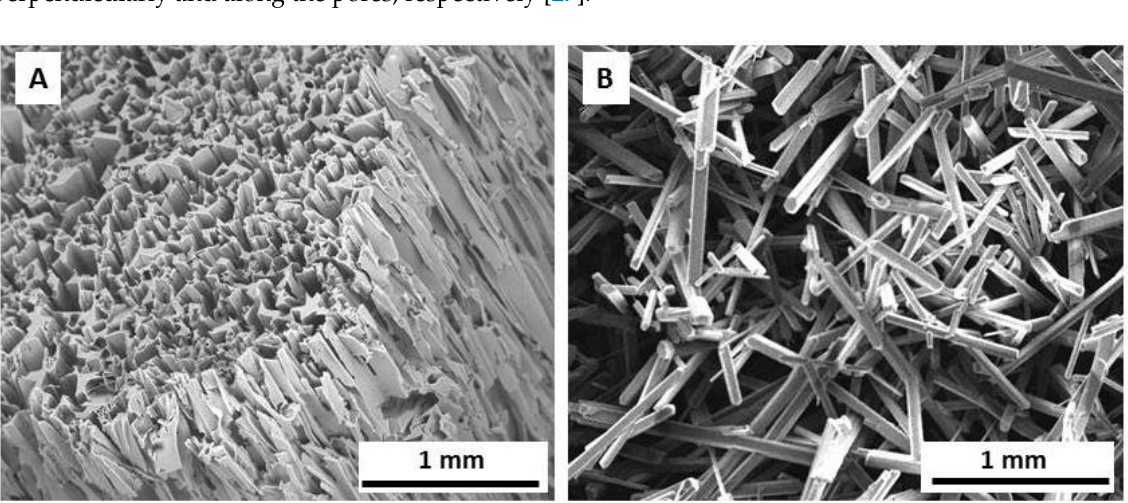
Figure 1. SEM micrographs of HEMA hydrogel ( A ) and ammonium oxalate crystals ( B ).